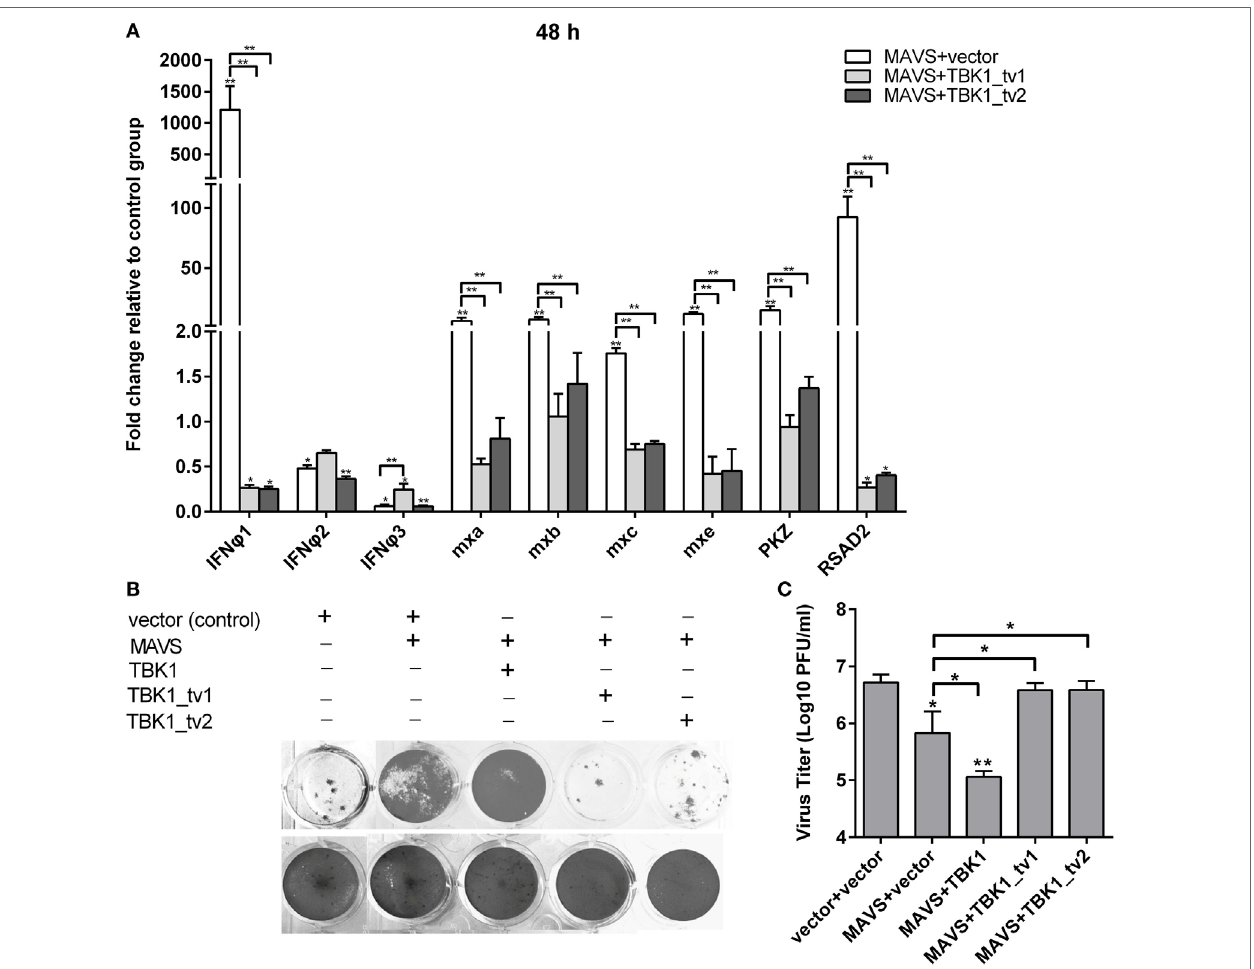
FigUre 4 | TANK-binding kinase 1 (TBK1) isoforms are negative regulators for mitochondria antiviral-signaling protein (MAVS)-mediated innate immunity. (a) Effects of zebrafish TBK1_tv1 and TBK1_tv2 isoforms on expression of interferons (IFNs) and IFN-stimulated genes induced by MAVS. Embryos were microinjected at the one-cell stage with 100 ng of indicated expression construct. At 48 h postfertilization, 15 embryos for each sample were used for RNA extraction. The p3xFLAG- injected group was used for control. Data were expressed as mean ± SEM of three independent experiments. * p < 0.05, ** p < 0.01. (B) Effects of zebrafish TBK1 and its isoforms on antiviral activity mediated by MAVS. The upper panels were transfected cells with spring viremia of carp virus (SVCV) infection. The lower panels were transfected cells without infection. (c) Effects of zebrafish TBK1 and its isoforms on SVCV replication mediated by MAVS. Epithelioma papulosum cyprini cells seeded overnight in 24-well plates at 3 × 10 5 cells per well were transiently transfected with 400 ng various indicated plasmids. Thirty hours post-transfection, the cells were infected with SVCV at a multiplicity of infection of 5. Another 48 h later, the supernatants were collected for the determination of virus titers by standard plaque assay. Plates fixed in 10% paraformaldehyde for 1 h were stained with 0.5% crystal violet and photographed. Data represent mean ± SEM ( n = 3) and were tested for statistical significance. * p < 0.05, ** p <